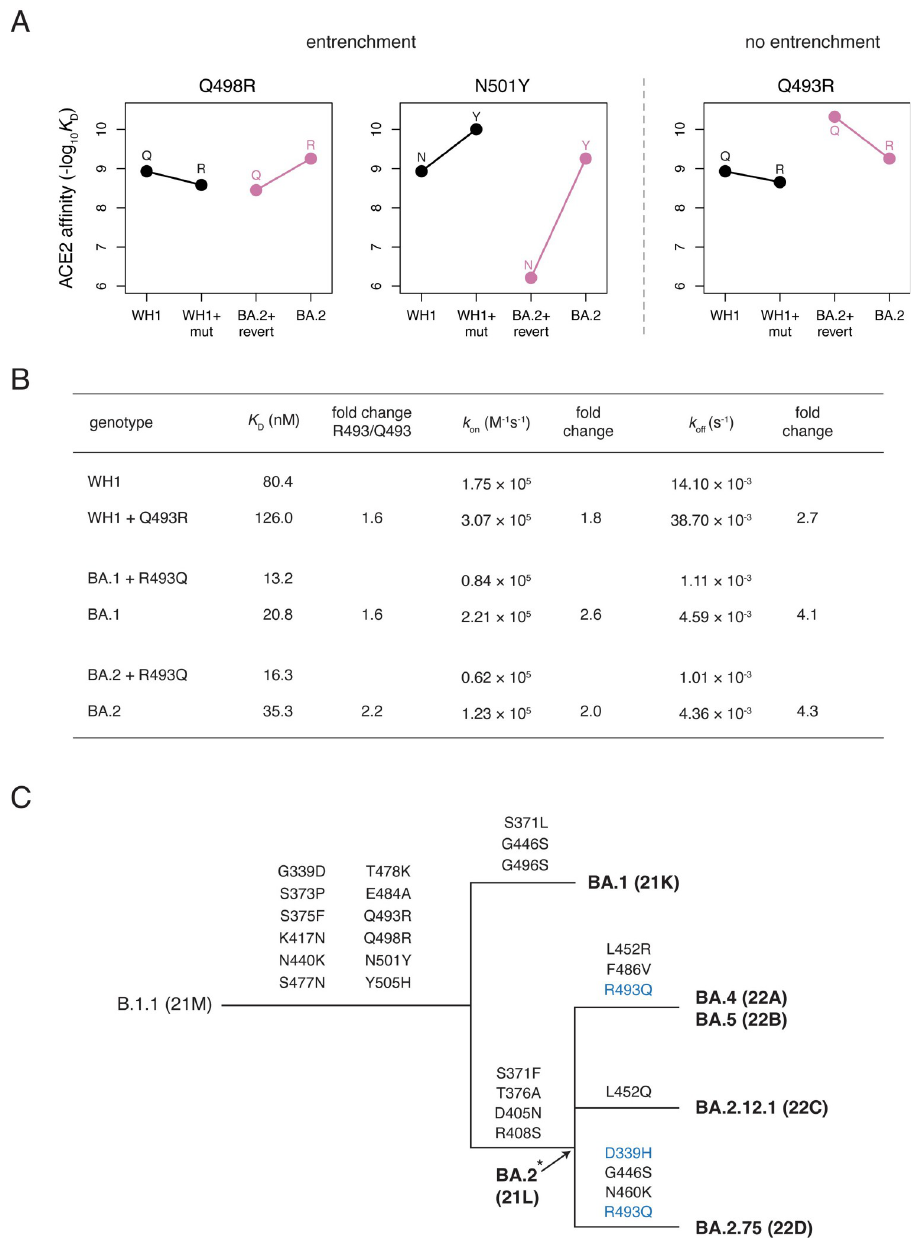
Fig 3. Entrenchment (or lack of entrenchment) of Omicron substitutions. (A) Patterns of entrenchment (or lack thereof) of Omicron substitutions Q498R, N501Y, and Q493R. Each plot shows the effect of the labeled mutation (“mut”) as measured in Wuhan-Hu-1 (WH1, black) or its reversion (“revert”) in Omicron BA.2 (pink). A difference in the slope of the lines connecting the ancestral (left) to derived (right) state affinities illustrates epistasis. Entrenchment is evident in mutations where the slope of the pink line is greater (more positive or less negative) than the slope of the black line and arises from favorable epistasis between the entrenched substitution and one or more other co-occurring substitutions. See S6 Fig for entrenchment patterns at all substituted Omicron BA.1 and BA.2 positions. (B) Measurement of binding kinetics of Q493R mutants via biolayer interferometry (BLI). Kinetic parameters and fold- change of R493 compared to Q493 value are given. See S7 Fig for raw BLI sensorgram traces and parameters from a second biological replicate. (C) Schematic cladogram illustrating the relationship of major Omicron sub-variants and history of RBD substitutions. Secondary substitutions and reversions of basal Omicron substitutions are marked in blue. Asterisk indicates that the representation of BA.2 being a direct ancestor of all shown descendant lineages is